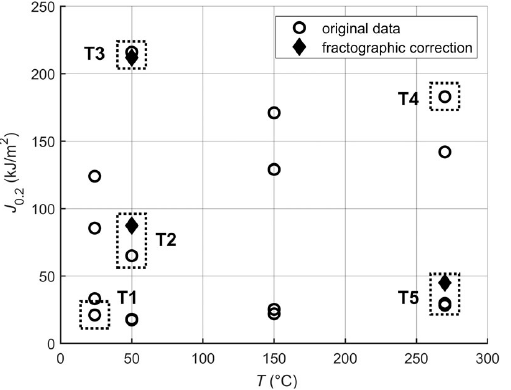
Figure 1. Results of static fracture toughness tests. Specimens T1–T5 selected for detailed metallo- graphic and fractographic analysis are enveloped.